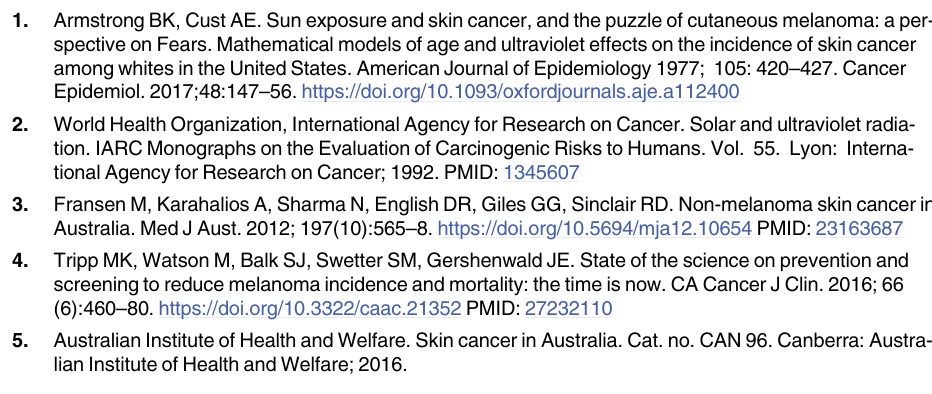
S3 Table. Mean change in the proportion of the body protected by sunscreen, clothing, or a hat when outdoors per decade, relative to before the SunSmart